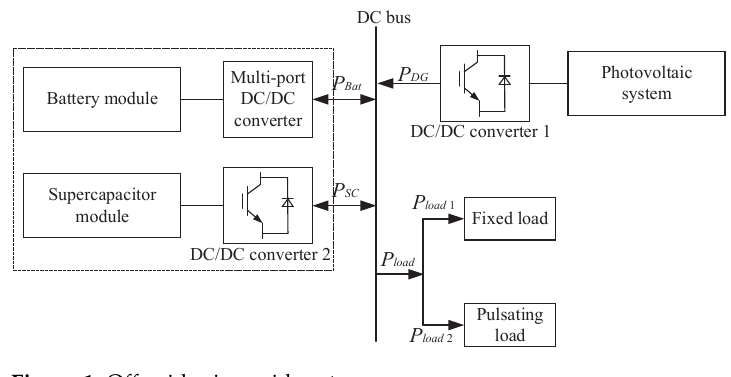
Figure 1. Off-grid microgrid